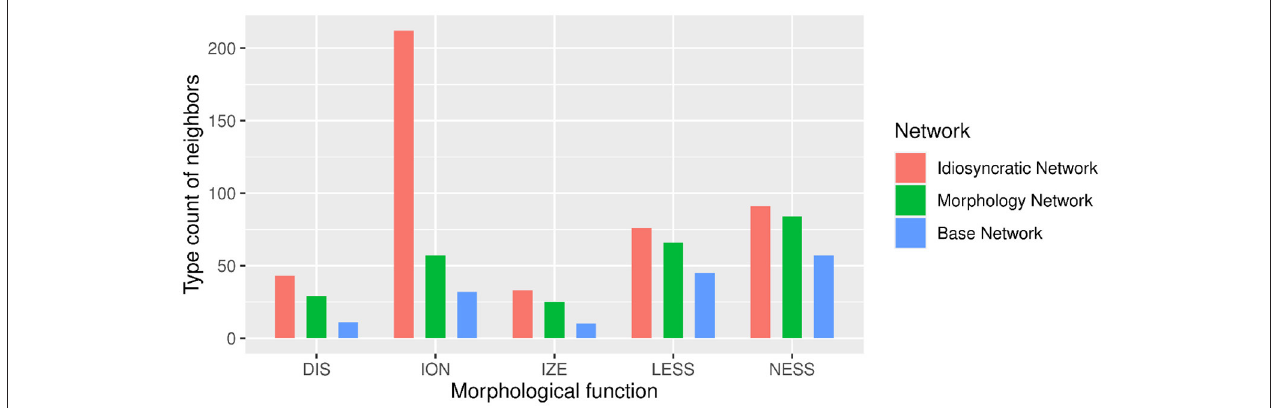
FIGURE 6 | Type count of top 8 neighbors by network and morphological